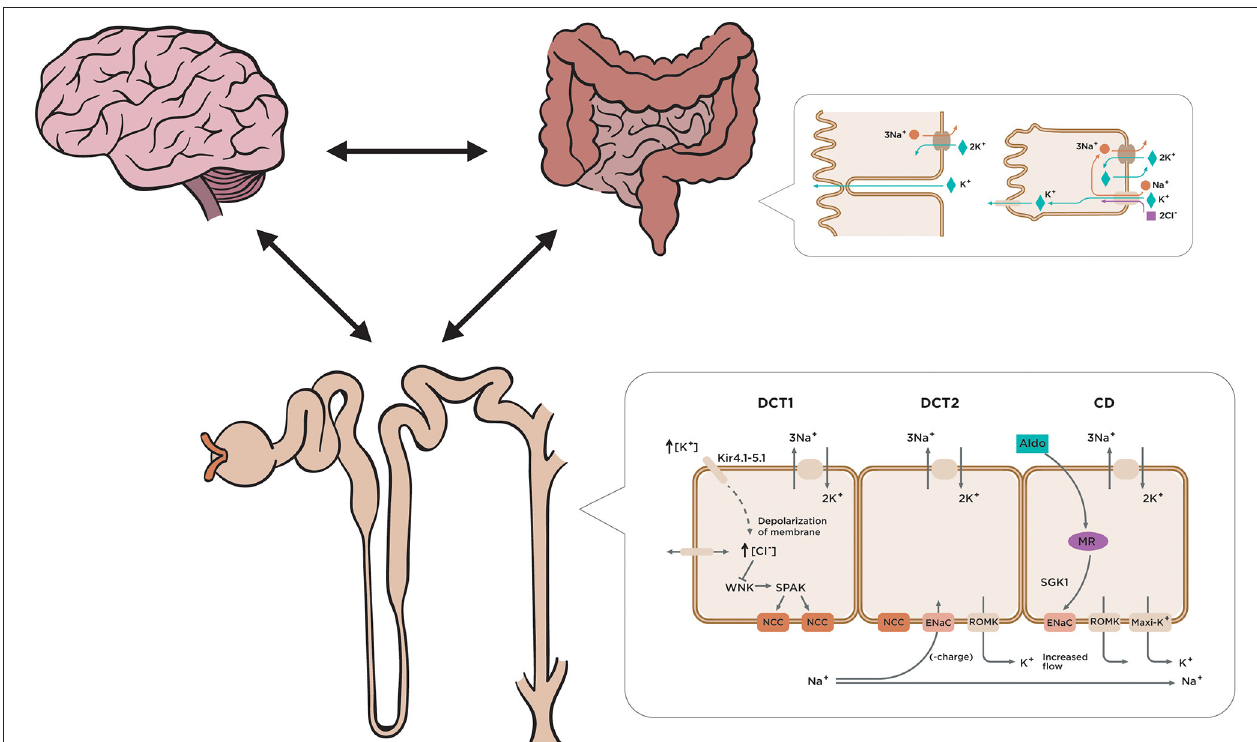
FIGURE 1 | Regulation of external and internal potassium balance. So-called feed-forward control refers to a potassium control pathway that responds to a pre-determined signal from the organism and is highly relevant to the mechanism of additional potassium regulation. The brain generates a regulatory circuit with the kidney and the colon that anticipates the presentation of food. Gastrointestinal-renal signals with a kaliuretic effect are generated, which will be able to mediate renal potassium elimination independent of changes in serum potassium and aldosterone concentration. Several co-transporters and ion channels are involved in the complex regulatory system of potassium reabsorption. The distal convoluted tubule mediates reabsorption of 5–10% of filtered potassium. Increased plasma K + concentration depolarizes cells in the proximal portion of the distal convoluted tubule (DCT1) through effects dependent on the potassium. Increased Na + delivery and flow to the downstream distal portion of the DCT where aldosterone sensitivity begins (DCT2, connecting tubule, and collecting duct) along with increased aldosterone levels drive potassium